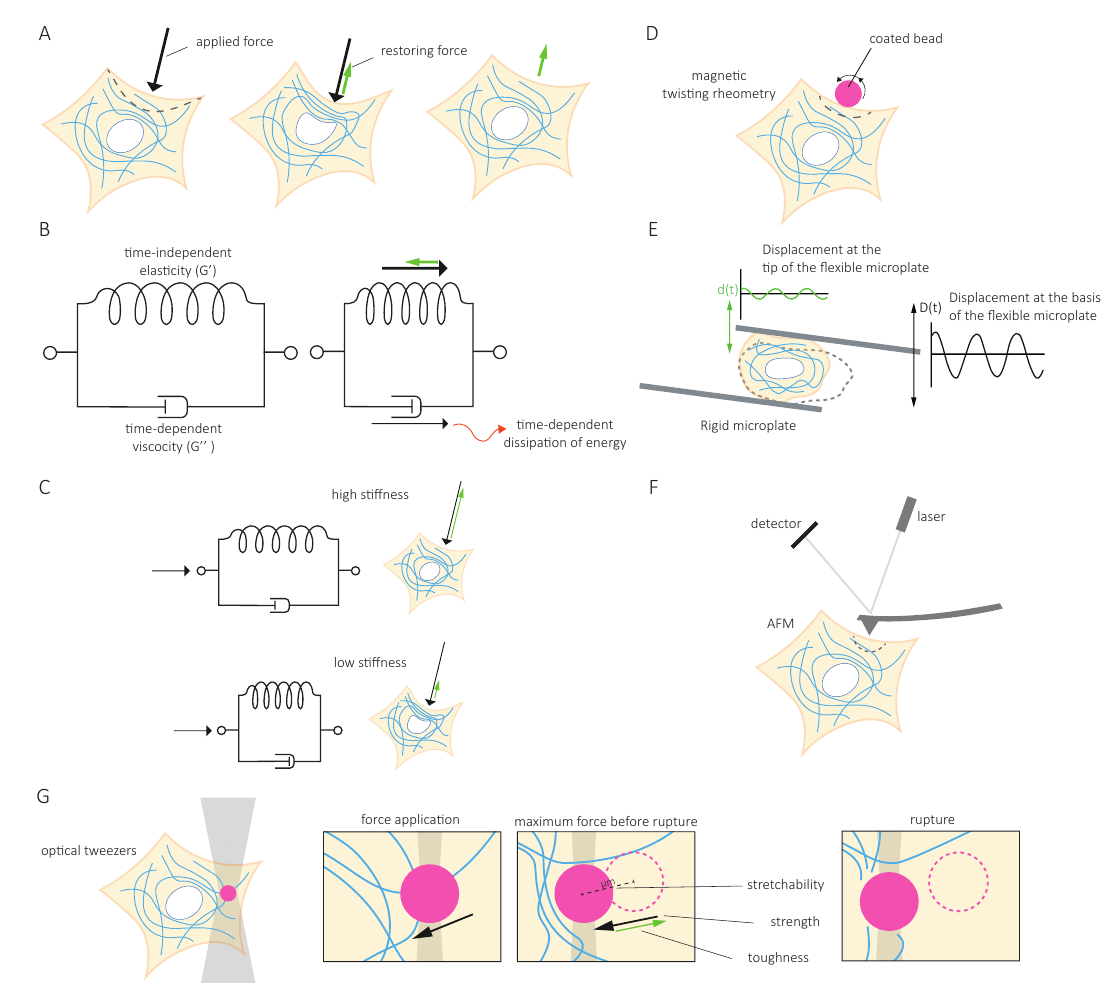
Figure 2. Intermediate filaments and cell-intrinsic mechanical properties. ( A ). When a force is applied to a cell (black arrow), part of the energy used to induce cell deformation (grey dashed line) is stored. Once the force is no longer applied, the stored energy is used to generate a restoring force (green arrow) which reduces (or abolishes) the deformation. ( B ). The deformability of the cell and its ability to return to its original shape depend on its viscoelastic properties. A cell both behaves as an elastic solid and a viscous fluid. Elasticity makes a cell resistant to deformations, comparable to a spring, where the energy that induces the deformation is stored in the material independent of time. Viscosity makes material flow like a fluid (represented as a damper) where the material’s resistance depends on the rate of deformation, and the energy that is put into the deformation is not stored in the material but is dissipated. The elastic modulus is indicated by G’ and the viscous modulus by G” in Pa. ( C ). To indicate the overall resistance of a cell against deformation, the overarching term stiffness is used. Stiffness does not distinguish between the elastic and viscous properties of the material. ( D ). Twisting magnetic beads coated with different proteins which interact with the cell surface can be used to deform a cell and determine its resistance to deformation, e.g., stiffness. ( E ). Single-cell rheology, in which cells are deformed in between a rigid and a flexible microplate, can be used to determine cell stiffness from the displacement of the flexible microplates. ( F ). Atomic force microscopy determines the stiffness of cells by locally probing the surface of the cell using a cantilever which contacts the surface. The bending of the cantilever reflects the stiffness of the cell and is determined by the reflection of laser light from the cantilever detected by a photodiode detector. ( G ). Intracellular magnetic beads larger than the mesh size of the cytoskeleton can be controlled using optical tweezers. Dragging intracellular beads at a constant speed towards the nucleus increasingly deforms the cell, and the energy needed to reshape the cell after the force is released is stored (green arrow). In cells, the amount of energy that can be stored has a maximum, after which, the material yields and changes its behavior from elastic to plastic. This maximum, or peak force, defined as cytoplasmic strength, indicates how much force can be applied to the cell until it cannot recover from its deformation. The distance the bead can move until this peak force is reached is defined as stretchability ( µ m). The sum of all the energy the cell can take up is defined as cytoplasmic